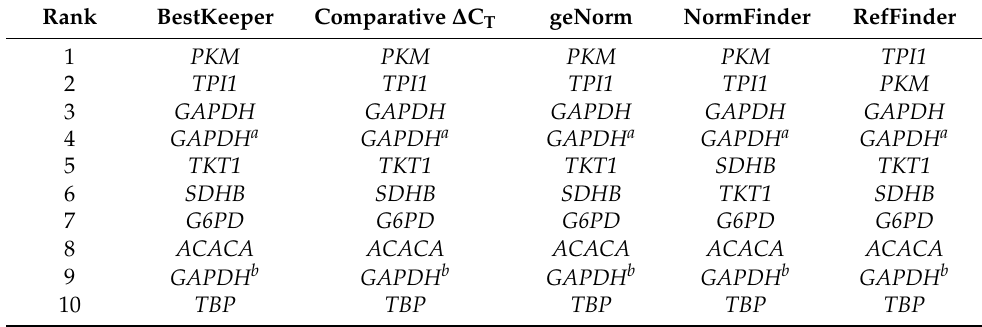
Table 5. Expression stability ranking of the selected candidate reference genes using